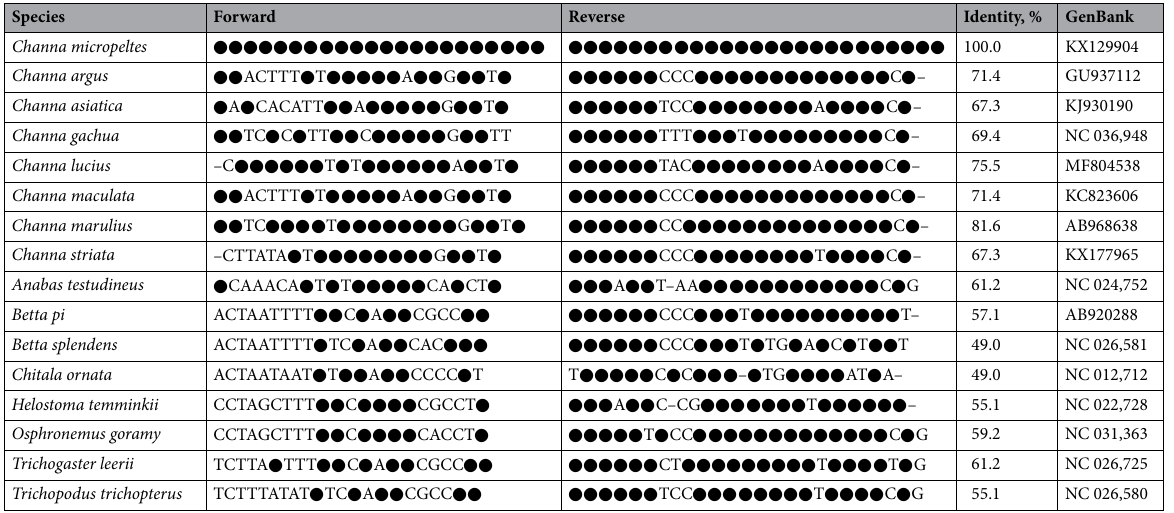
Table 1. Homology of the query to the forward and reverse primers, percentage identity as a function of the number of matching base sites divided by 47 (total number of base sites across the primer pair) Base site homology between the query and the primer is shown as a